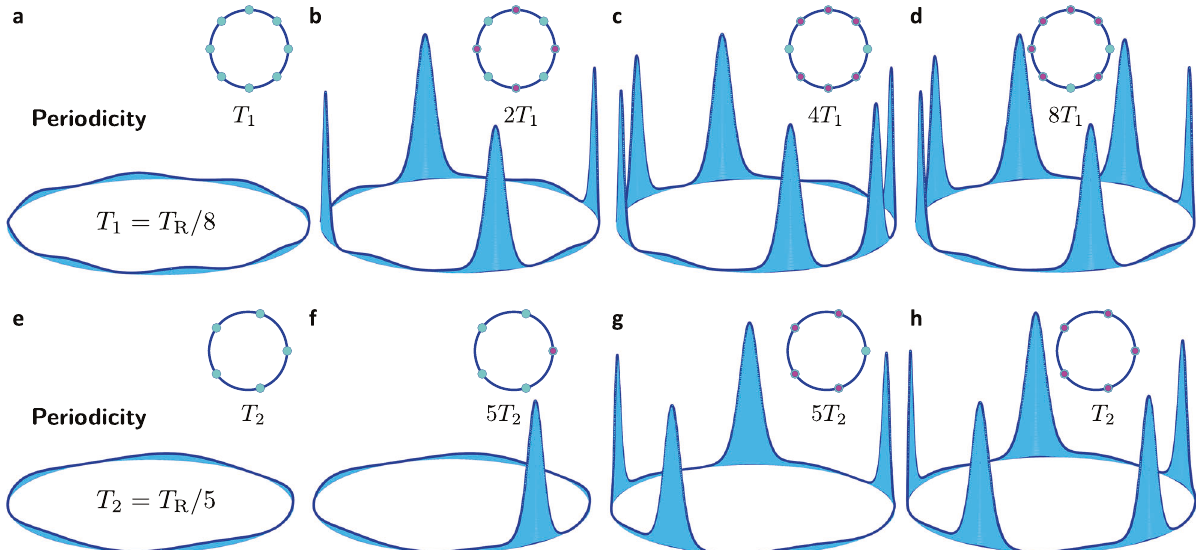
Fig. 1 DTCs in a Kerr nonlinear optical resonator pumped by two lasers. Symmetry breaking, period multiplication, and DTC formation in an optical resonator pumped by two lasers separated by a – d M = 8 and e – h M = 5 cavity FSRs. a , e The beating between the two pumps modulates the background waveform and creates a rotating lattice trap near the resonator periphery, where optical modes are localized. a For M = 8 the temporal periodicity of the lattice trap is T 1 = T R /8. b Spontaneous formation of a soliton in every second well of the lattice potential breaks the discrete TTS giving rise to a period- doubling DTC (periodicity 2 T 1 ). c When a trapped soliton is missing in every fourth potential well, a period-quadrupling DTC (with period 4 T 1 ) is formed. d If the distribution of multiple solitons in the lattice does not possess any certain symmetry, a period-octupling DTC (with periodicity 8 T 1 ) will be created. Here, 6 solitons are asymmetrically trapped around the lattice. e Lattice periodicity is T 2 = T R /5 for M = 5. Symmetry considerations reduce the variety of observable DTCs in this case. When only one soliton is trapped in the potential lattice ( f ), or when all but one of the potential wells host a soliton ( g ), a period-quintupling DTC is formed (periodicity 5 T 2 ), while if one soliton is trapped in each potential well, discrete TTS will not be broken ( h ). Insets illustrate top-view schematics with an empty circle (cyan) for each lattice trap and a fi lled circle (magenta) denoting a